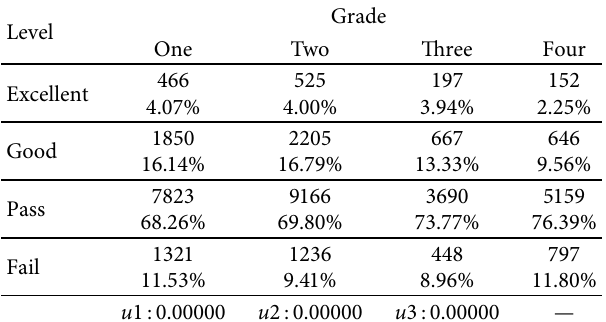
Table 5: Boys’ standing long jump scores and grade